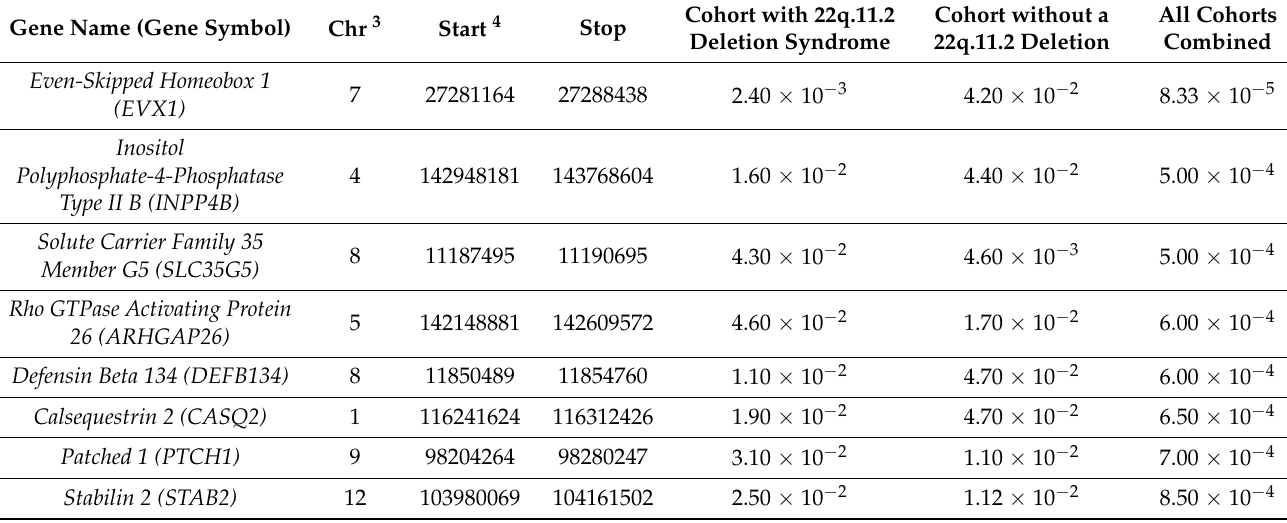
Table 1. Summary data for genes with p < 1.0 × 10 − 3 , by cohort 1,2 .